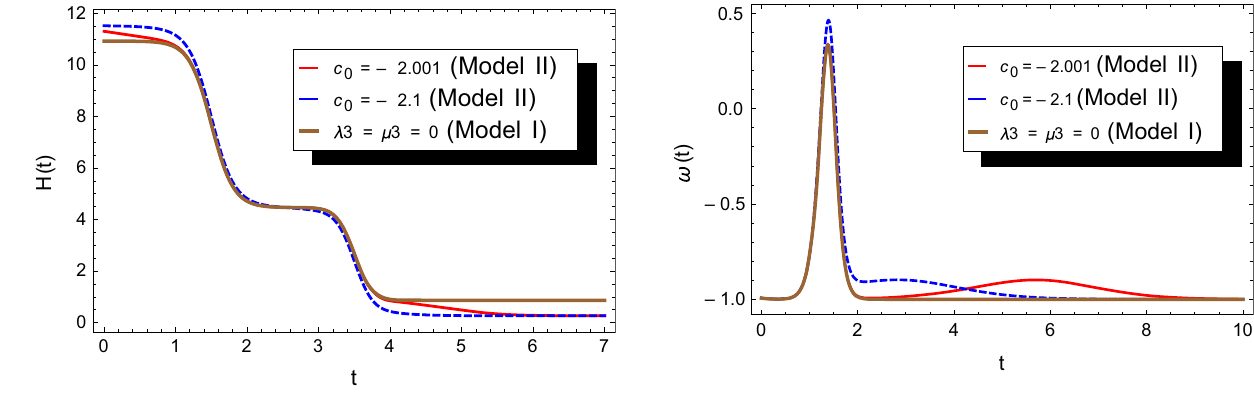
Fig. 7 Behavior of the equation of state with λ 1 = 2 . 70, λ 2 = 3 . 23, and α 1 = α 2 = − 5 . 9. The (blue) dotted and (red) thin lines stands for λ = μ = 0 . 9 3 3